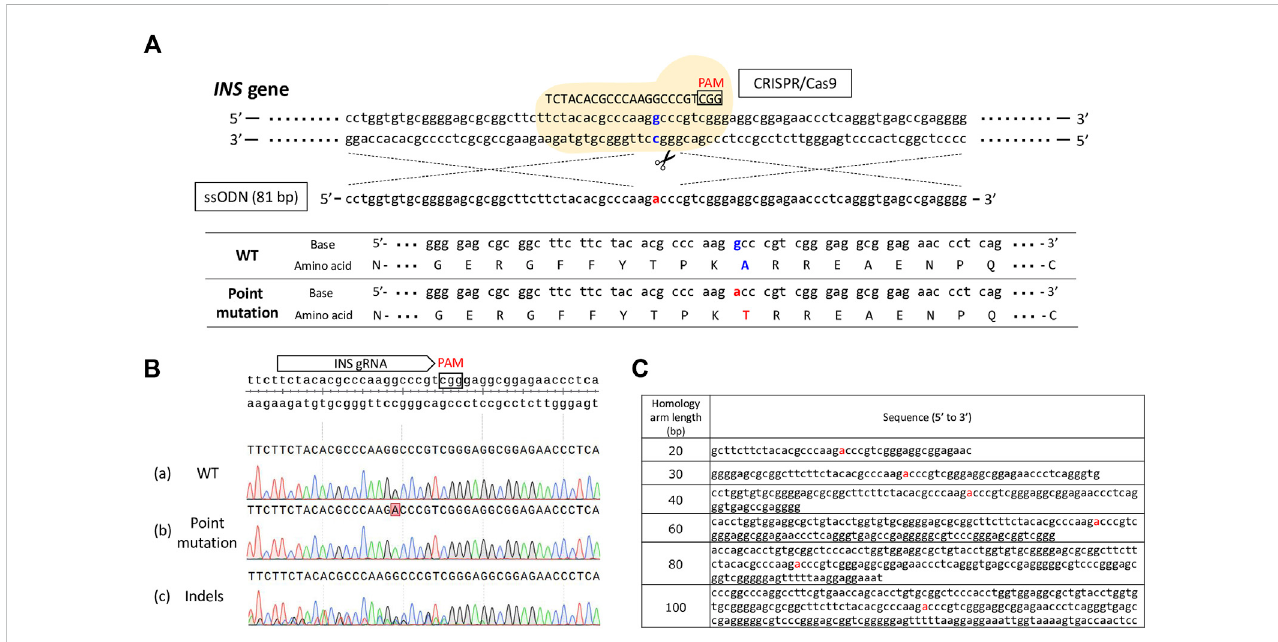
FIGURE 1 (A) Schematic of the experimental design to introduce a desired point mutation into the porcine INS gene. Electroporation was used to deliver the Cas9 protein, gRNA targeting the INS gene, and single-stranded oligodeoxynucleotide (ssODN) to porcine zygotes. The sequence of ssODN with 40 bp homologyarmsispresentedinthisillustration.The fl ankingaminoacidsequencesofthetargetsitebeforeandaftertheintroductionofthepointmutationare also presented. Mutated nucleotides and converted amino acids are indicated in red. The original nucleotide sequence in porcine INS gene and original amino acid sequence before the introduction of a point mutation are indicated in blue. PAM, protospacer adjacent motif sequence; WT, wild-type. (B) Representative results of Sanger sequencing of the blastocysts derived from electroporated zygotes with the Cas9 protein, INS gRNA, and ssODN. (a) Wild- type(WT)blastocyst.(b)Point-mutatedblastocyst.(c)BlastocystcarryingindelsintroducedbytheCas9proteinandgRNA. (C) SequencesofthessODNhaving various homology-arm